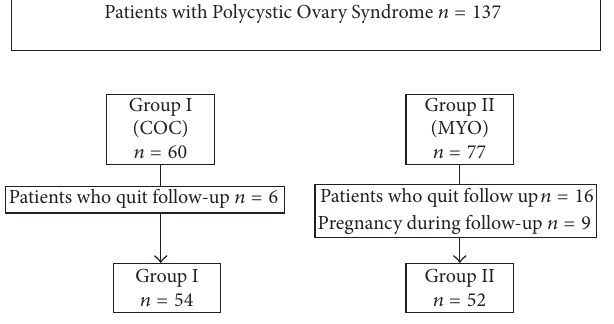
Figure 1: Flow chart of the